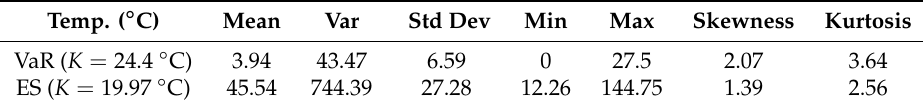
Table A4. Descriptive Statistics for monthly CDDs for the period of time 1970–2016 and 90% percentile